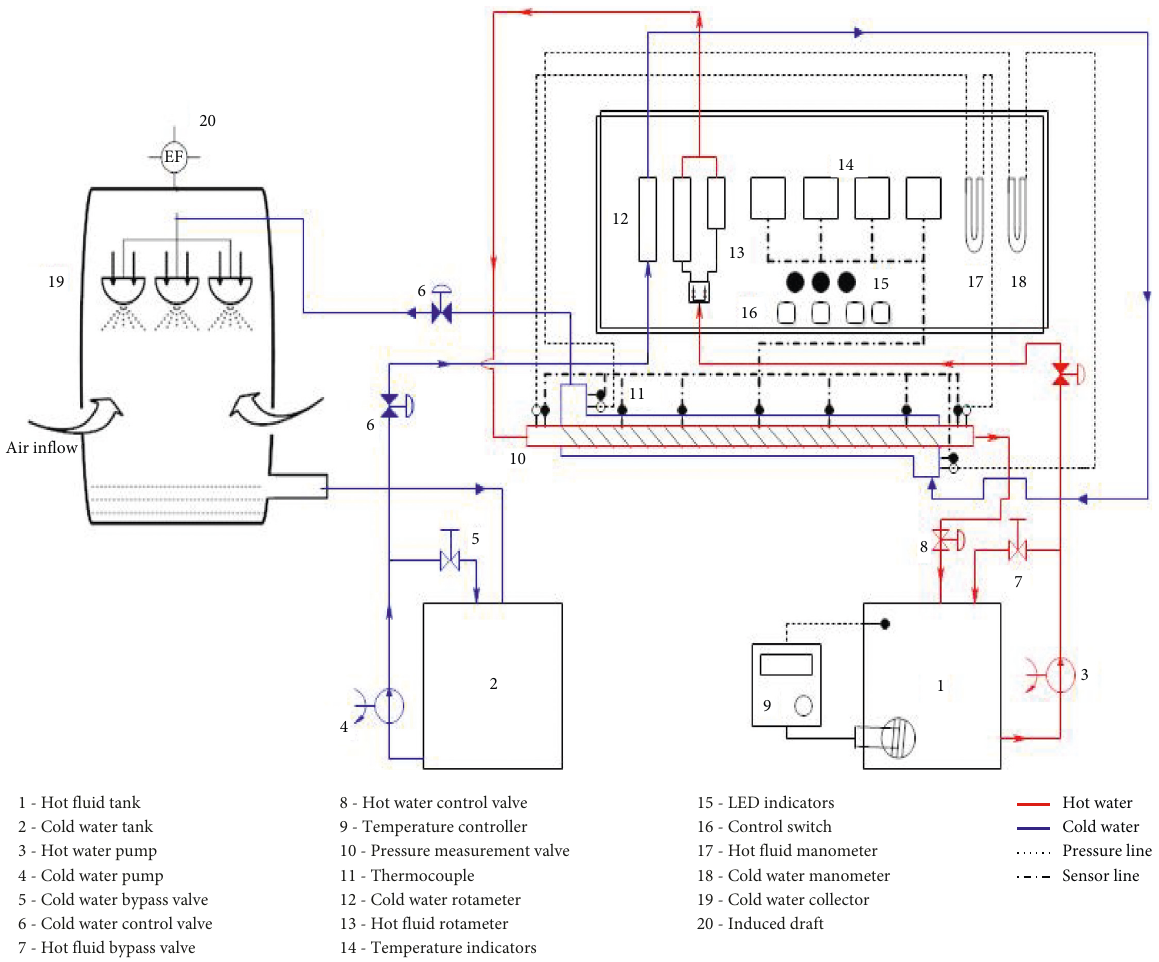
Figure 4: Schematic diagram of experimental